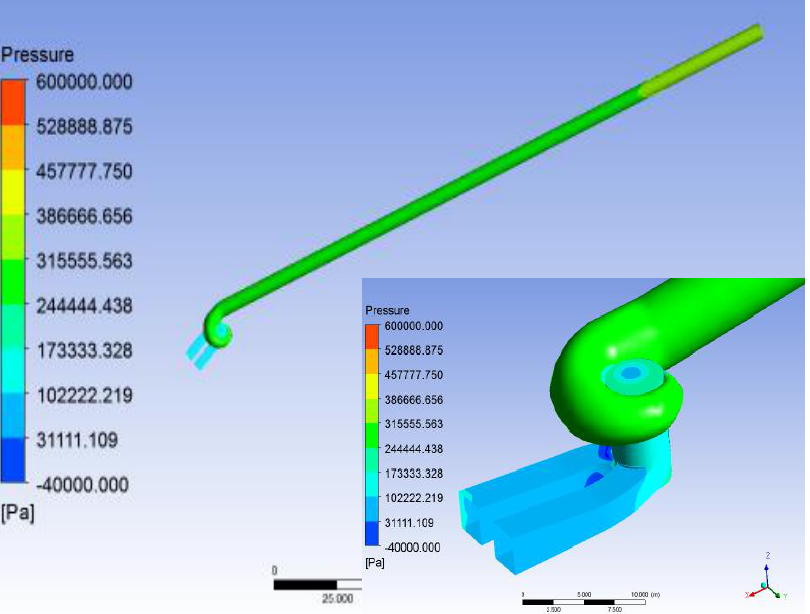
Figure 10. Velocity flow lines in Temenggor turbine unit.